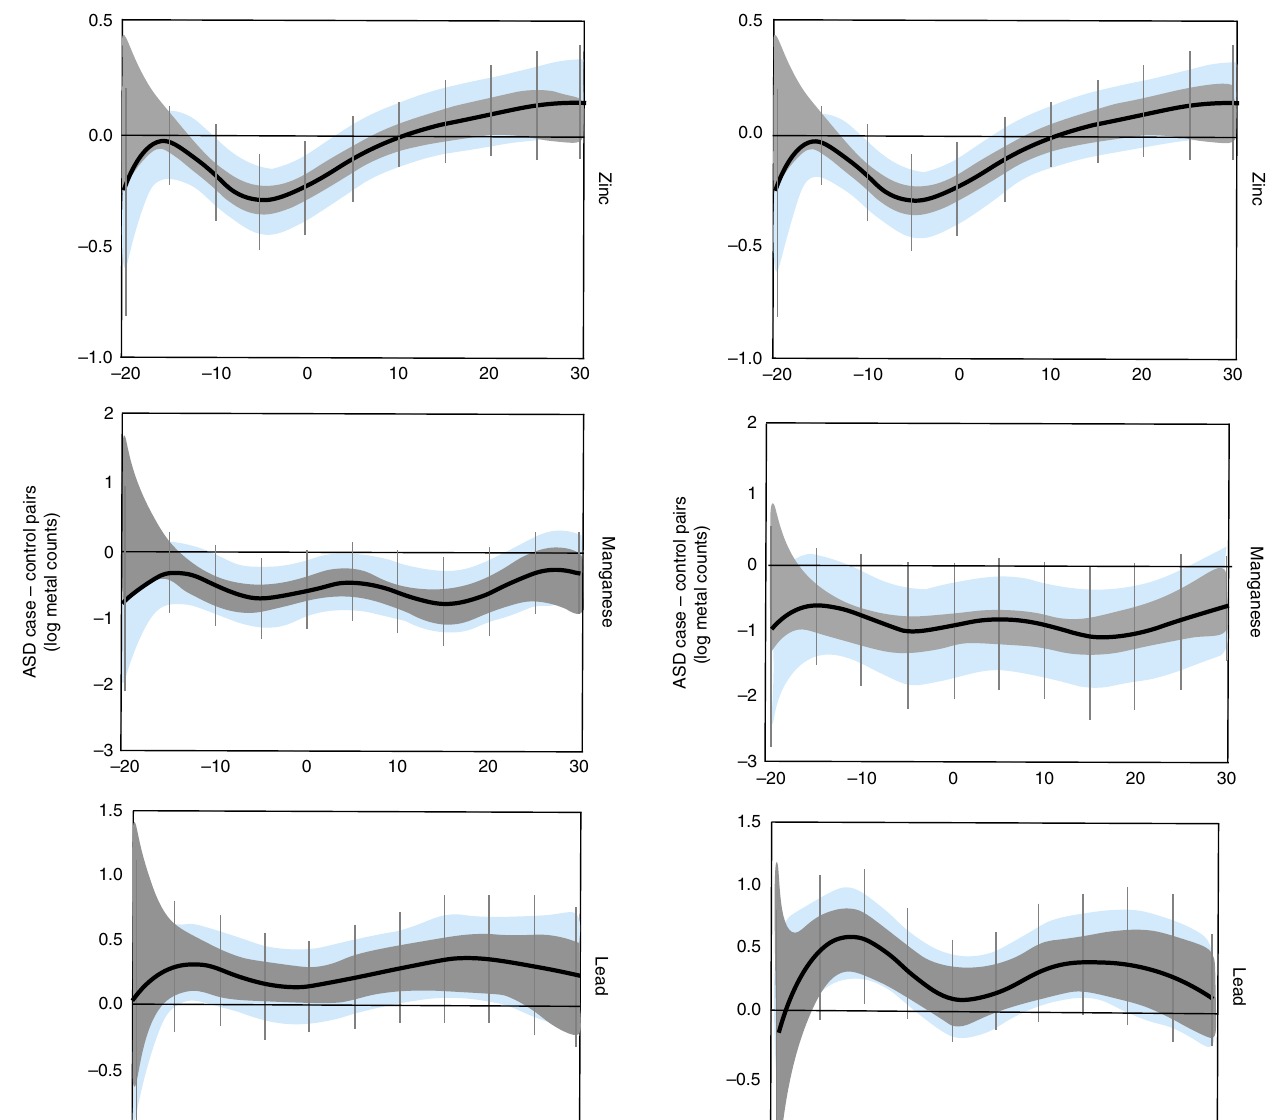
NATURE COMMUNICATIONS|8:15493|DOI: